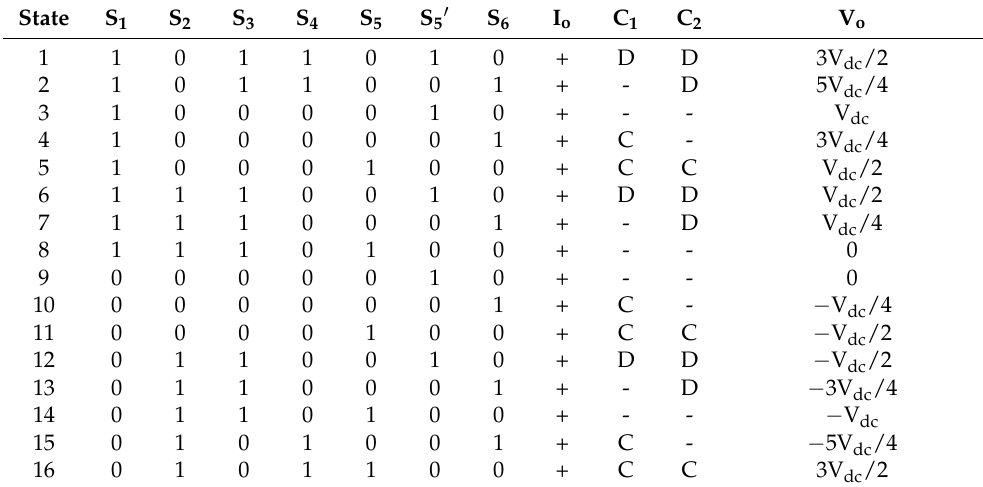
Table 1. States of WE-13